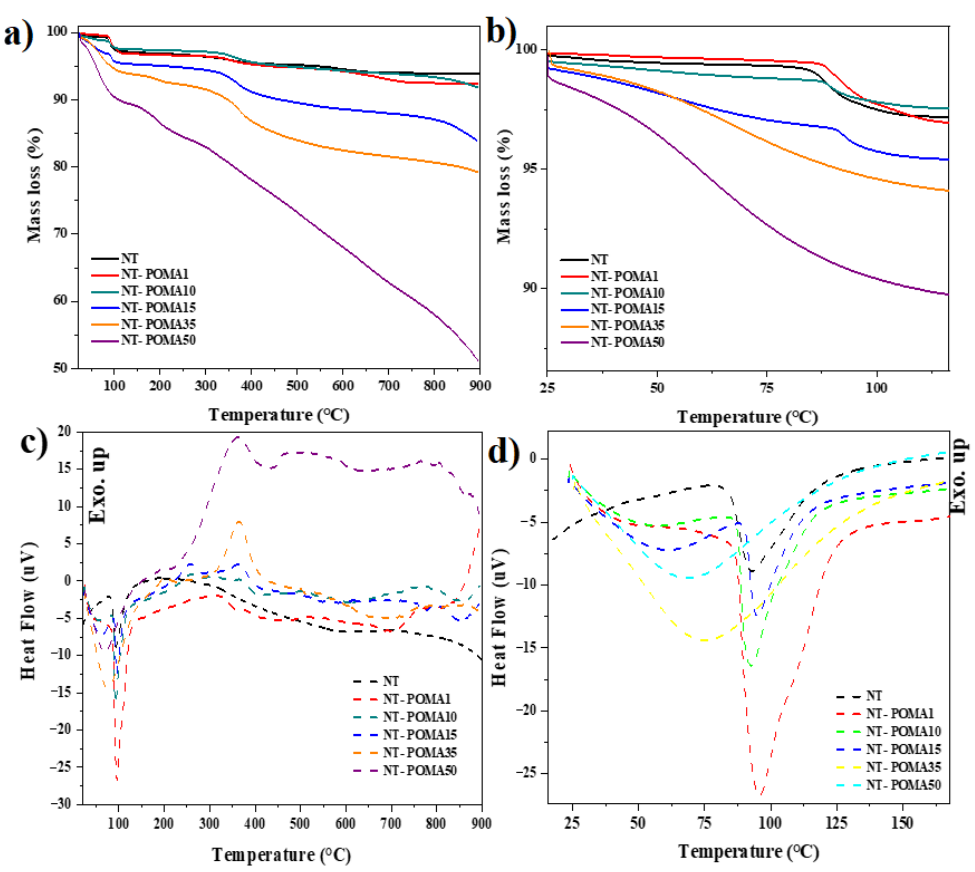
Figure 2. Thermogravimetric (TGA) and Differential Thermal Analysis (DTA) of Na 2 Ti 3 O 7 /Na 2 Ti 6 O 13 /POMA composites. ( a , b ) show the mass loss as a function of temperature determined from TGA; ( c , d ) show the heat flow as a function of temperature determined from DTA.